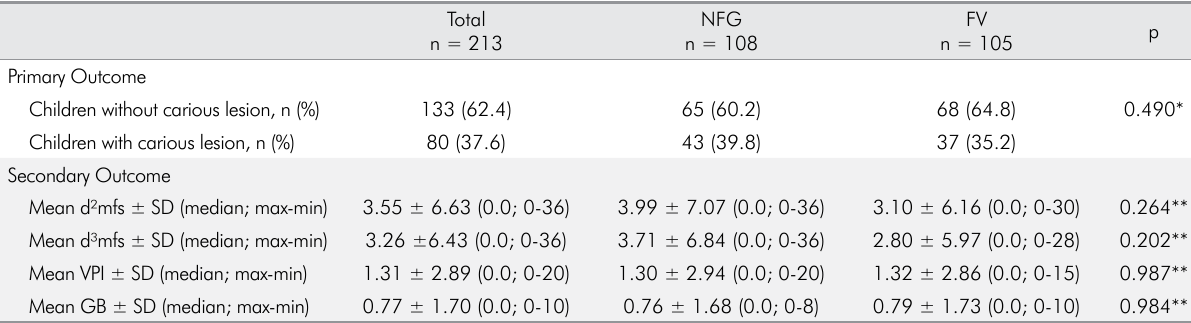
Table 3. Comparison of NFG and FV groups at the 12-month follow-up.